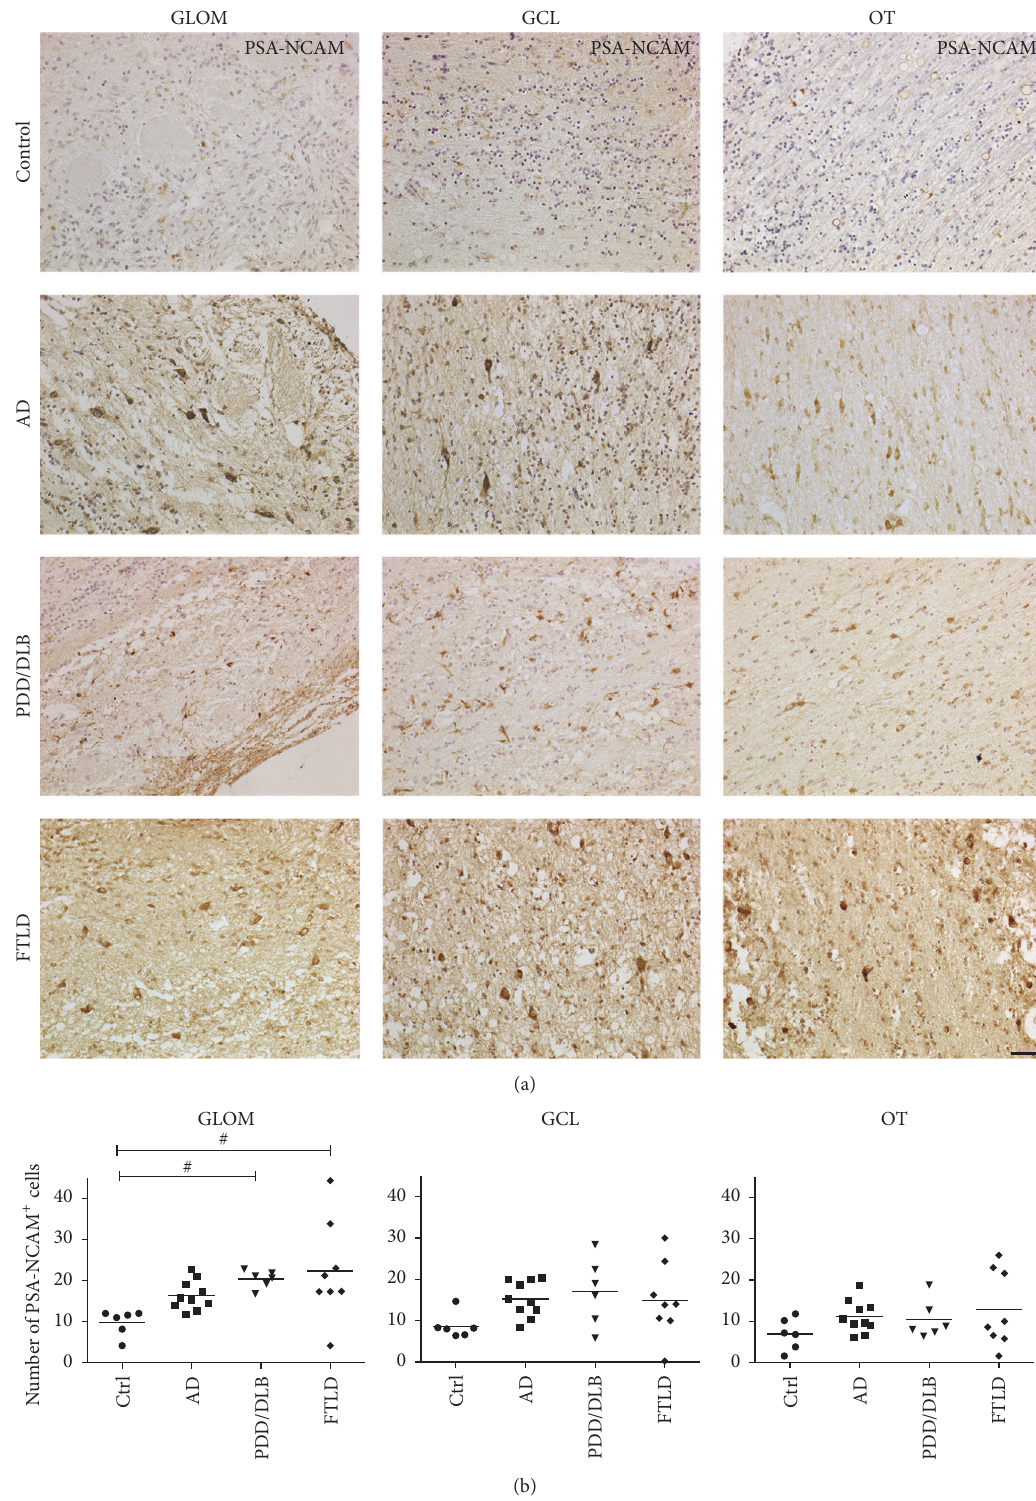
Figure 8: Increased number of cells expressing PSA-NCAM in the GLOM of PDD/DLB and FTLD patients. The number of cells expressing the immature neuronal marker PSA-NCAM was increased in the GLOM from PDD/DLB and FTLD cases, but not in AD patients, while in the GCL and the OT the number of cells was not altered compared to controls. (a) Representative images of cells expressing PSA-NCAM in all regions analyzed from controls, AD, PDD/DLB, and FTLD cases. Quantification presented in (b). 1-way ANOVA, Kruskal-Wallis post hoc test, # 𝑝 < 0.05 . Scale bar represents 50 𝜇